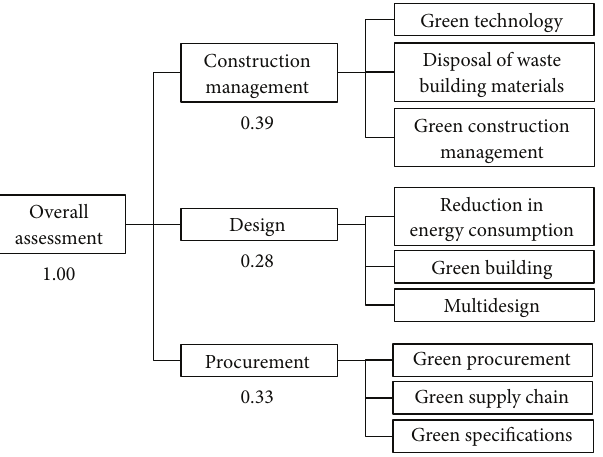
Figure 4: The AHP architecture of each